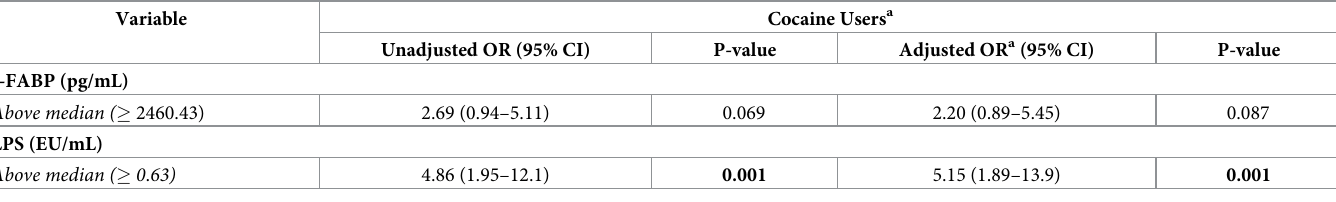
Above median ( � 0 . 63) Bold indicates statistical significance at P < 0.05. a